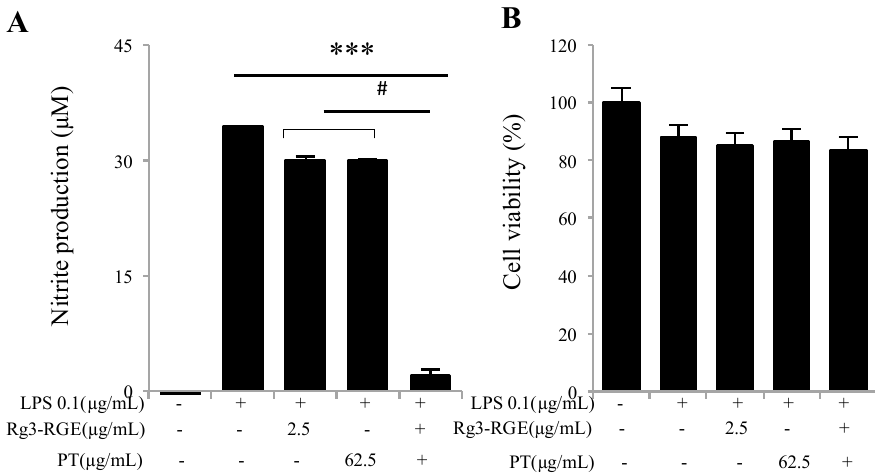
Figure 1. Bioactive compound analysis in Rg3-RGE and Persicaria tinctoria (PT). Chromatogram for the HPLC analysis of Rg3-RGE ( A ) with the respective ginsenosides identified as labeled on their respective peaks. UPLC–QTofMS analysis of PT and their identified peaks ( B ). Constituents of PT are summarized in Table 1.